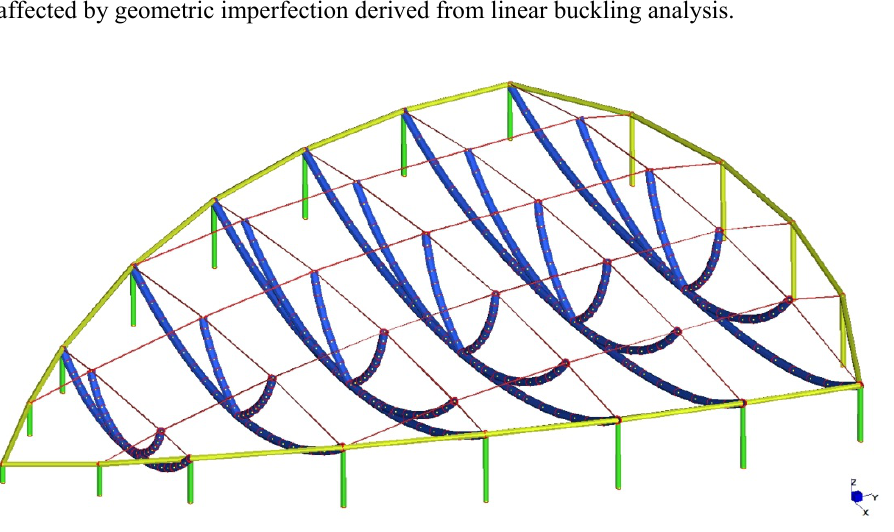
Figure 7: Finite Element Model of the steel